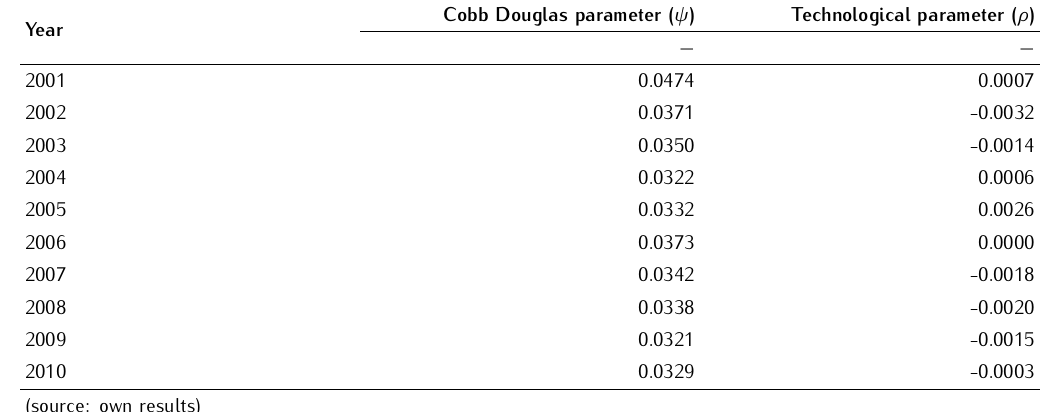
Table 1. Main parameters of the IC engine.